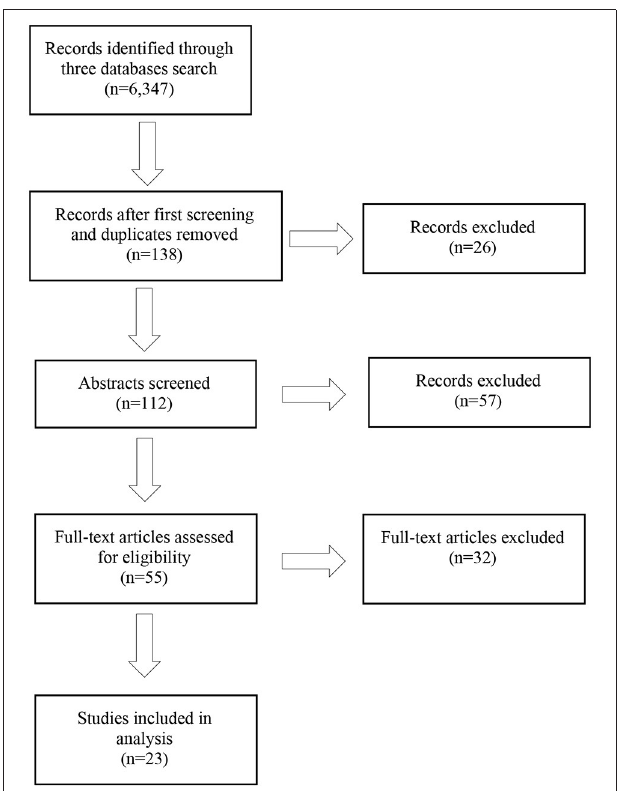
FIGURE 1 | Flow-chart of the screening